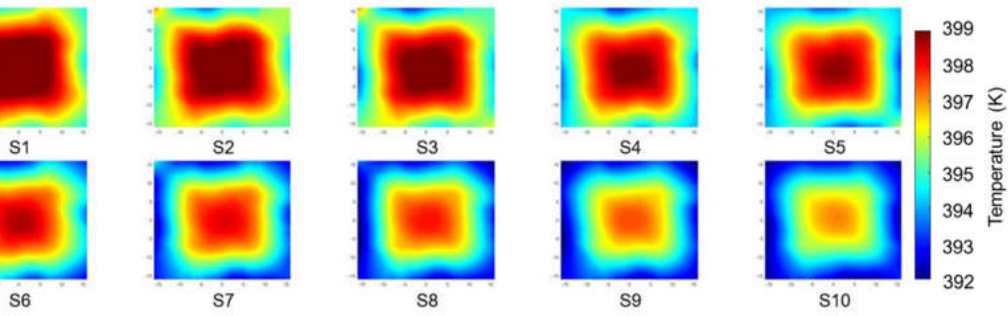
Figure 9. Temperature contours of different cross-sections of the “SS”.